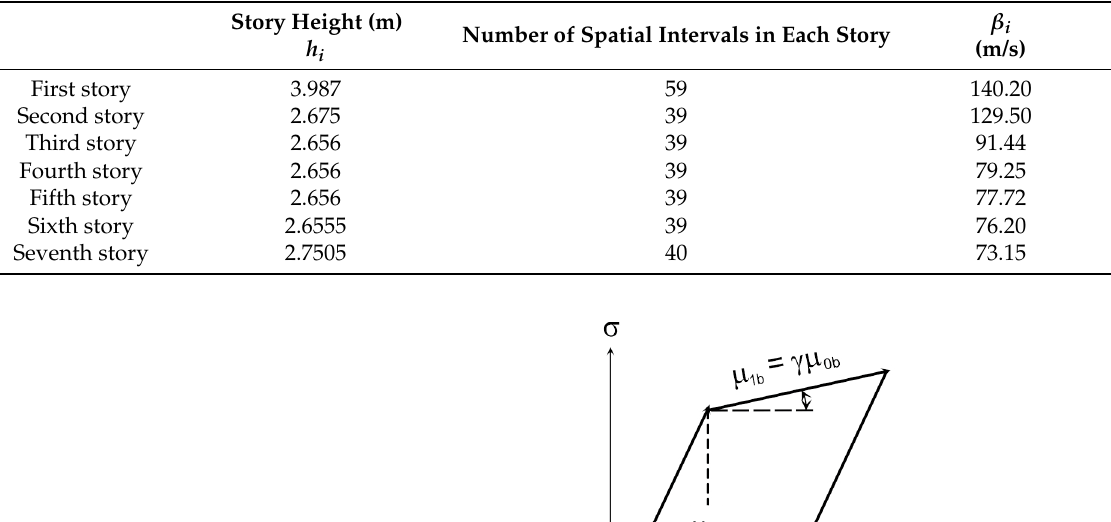
Table 1. One dimensional VN7SH model assumed to be fixed at its base.